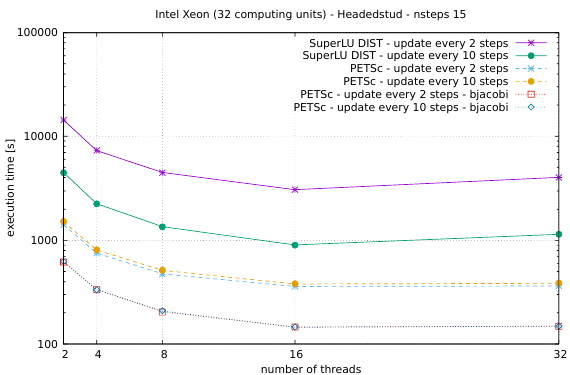
Figure 7. Execution times using the Modified Newton-Raphson method with secant stiffness updated after every 2nd and 10th iteration.